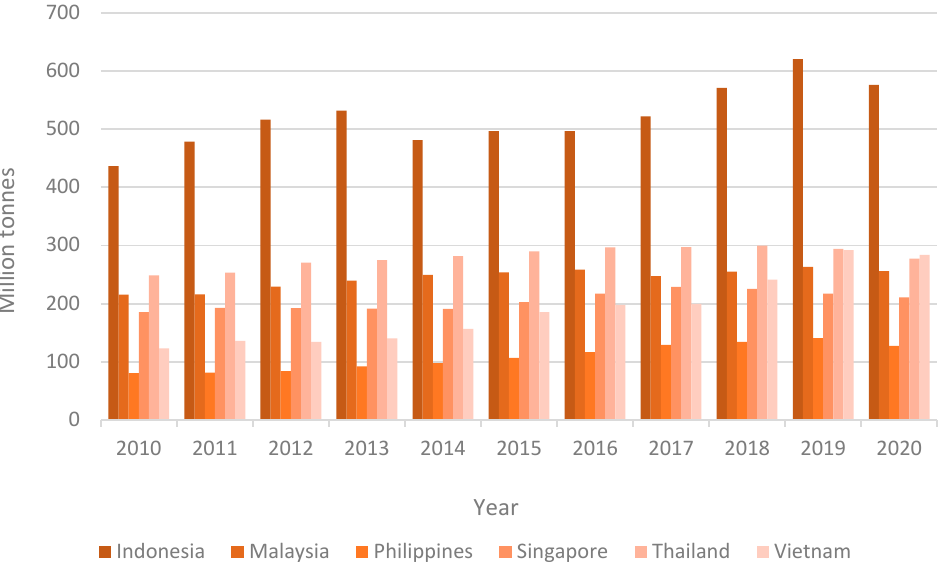
Figure 3. Carbon dioxide Emission in the Region (Million tonnes). source: Statistical Review of World Energy 2021|70th edition.